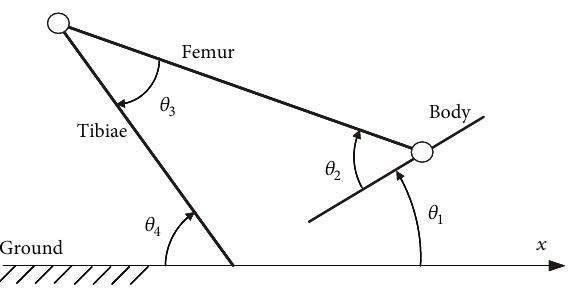
Figure 1: Simpli fi ed mechanical model of a L. migratoria